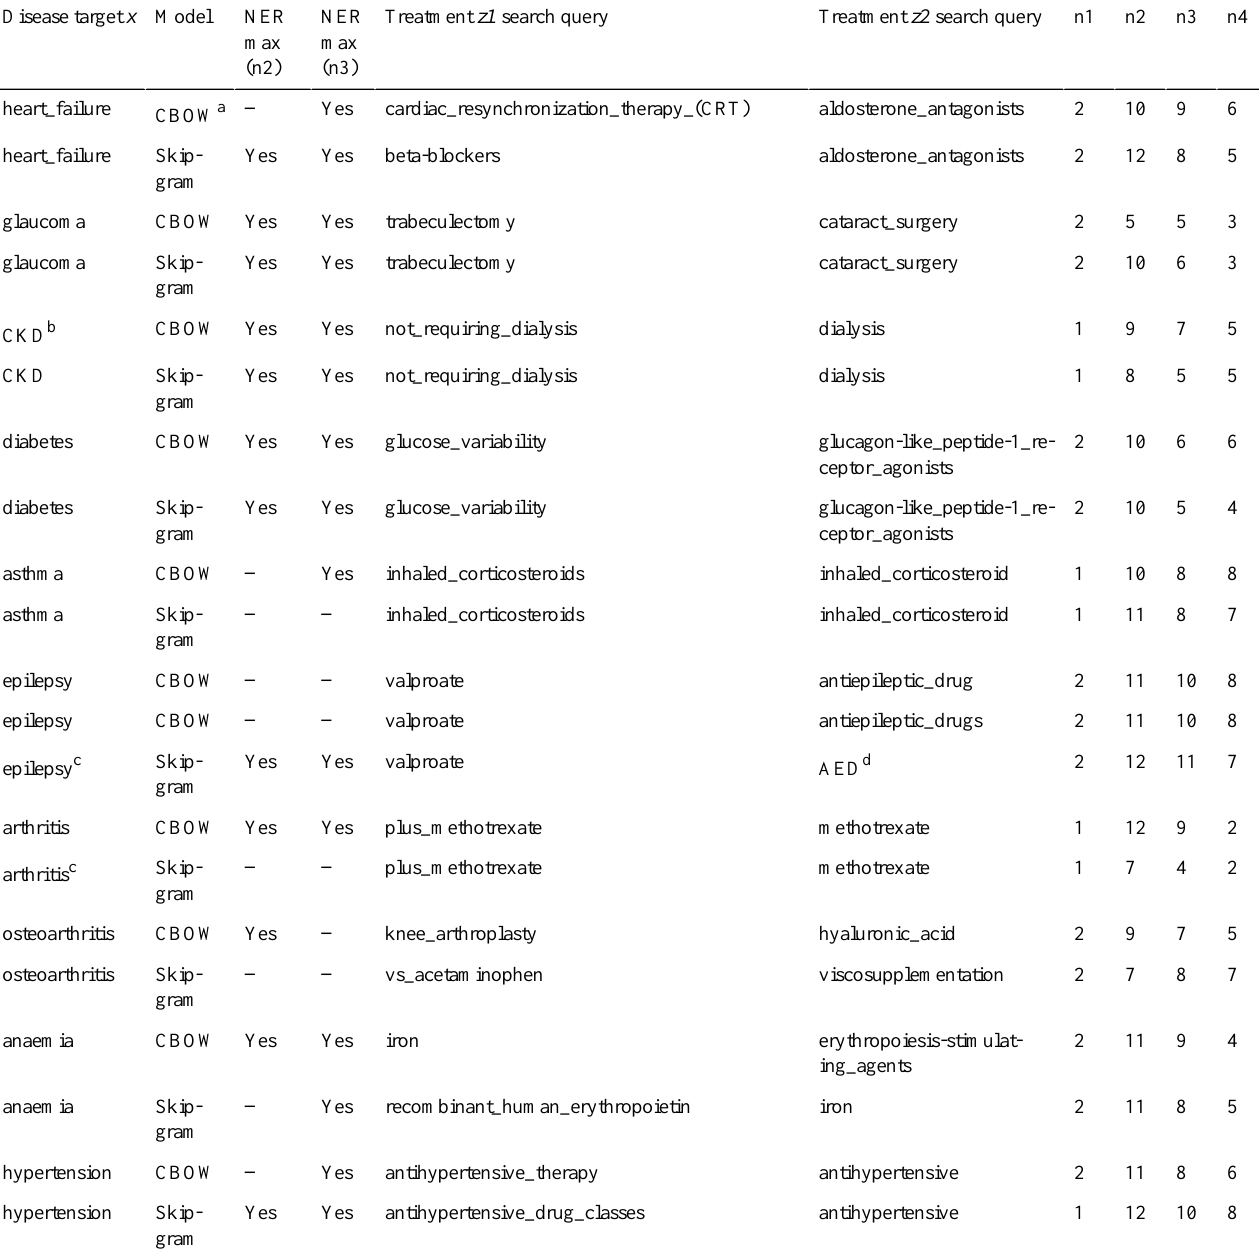
Table 4. Clinical winners (highest value of n4) per model and disease target x considering the 3 domain